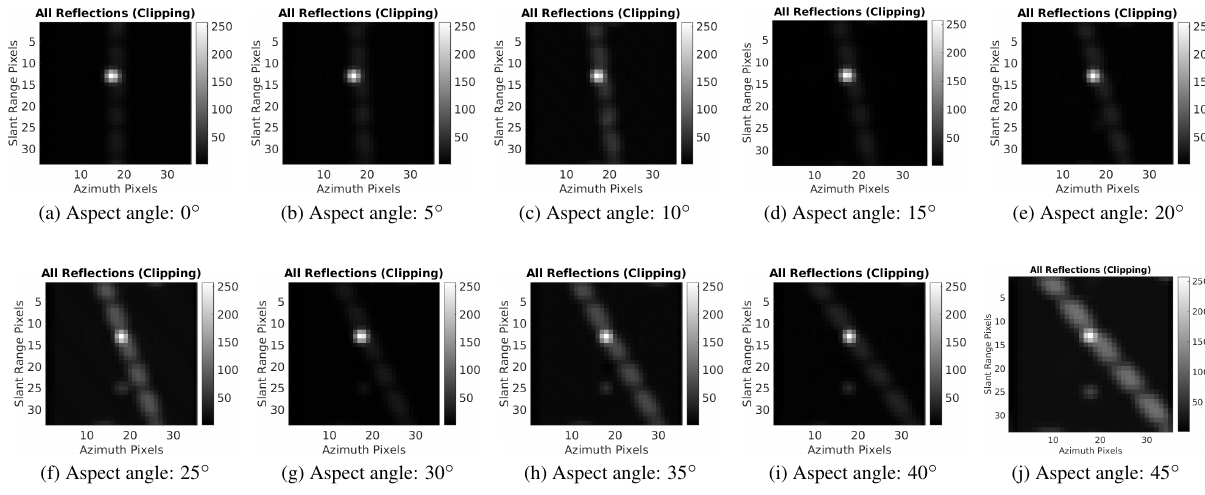
Figure 5. Simulated SAR images for light pole (spotlight